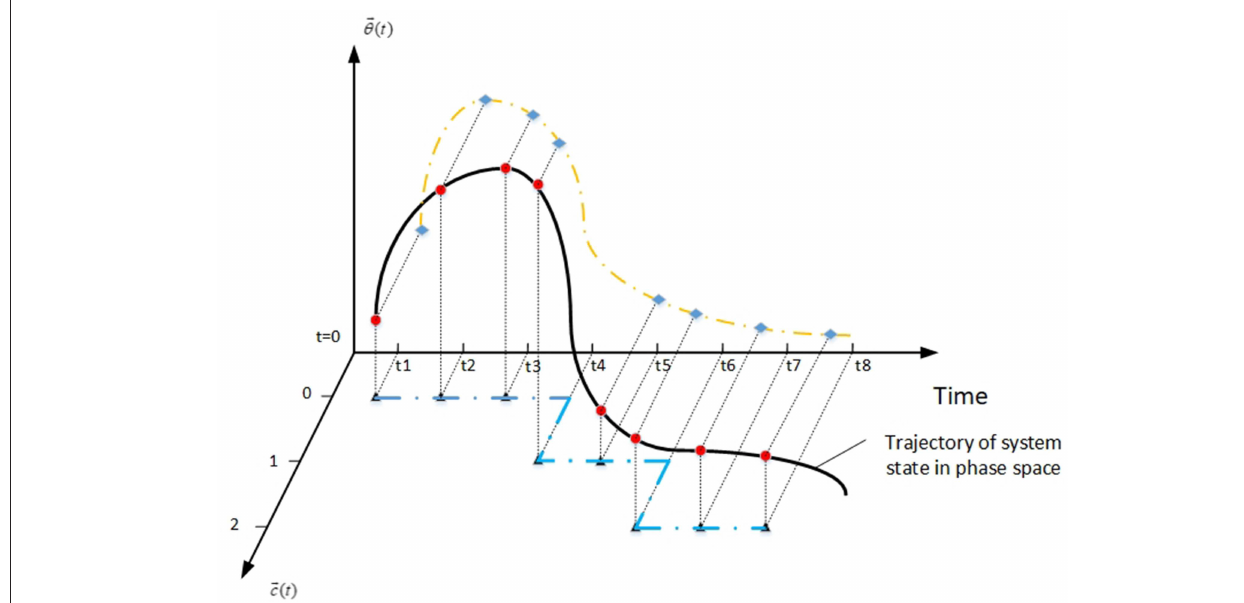
FIGURE 1 | The trajectory of system state in phase space.